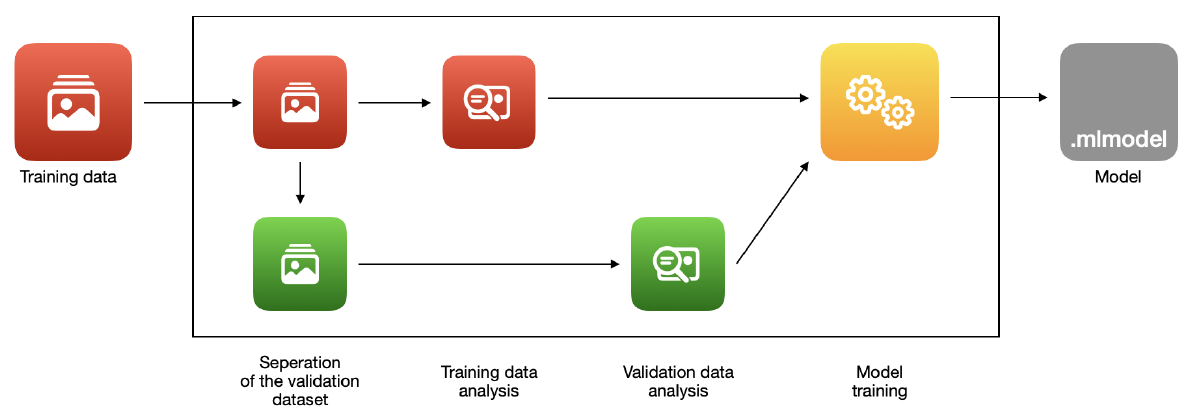
Figure 4. The stages of training an image classifier with ‘Create